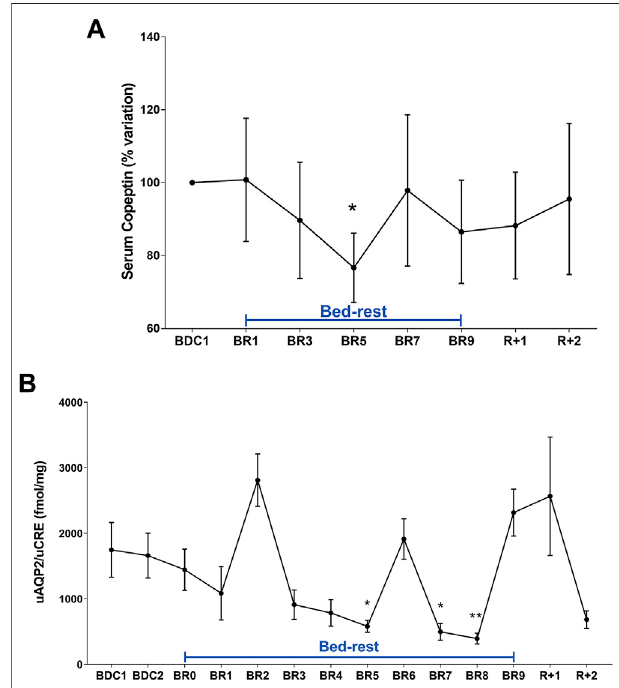
FIGURE 1 | (A) Serum Copeptin (% variation versus BDC1) during 10-day bedrest.Dataareexpressedasmean±S.E.M.Statisticalanalysiswasdoneusing One Sample t test (* p < 0.05 for BR5 vs. BDC1); (B) urinary AQP2 excretion normalized to Creatinuria (fmol/mg) during 10-day bedrest. Data